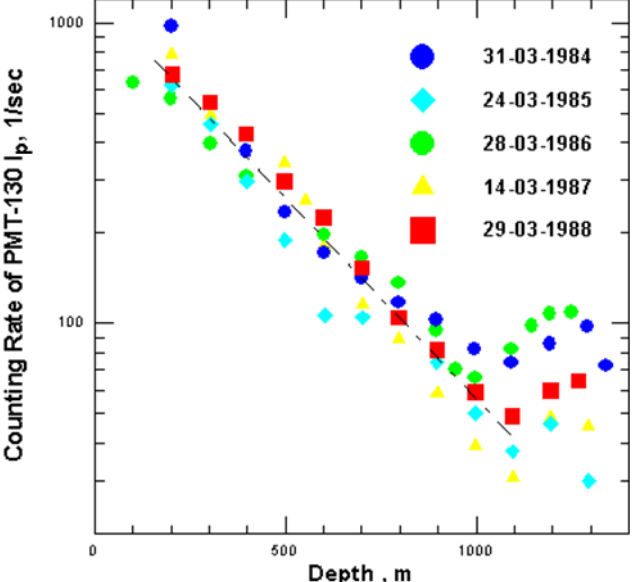
Figure 1. PMT counting rate I p depending on depth. The photon flux can be calculated from the countig rate as E p (photon cm -2 sec -1 ) = (3,5 ± 1,0) I p sec